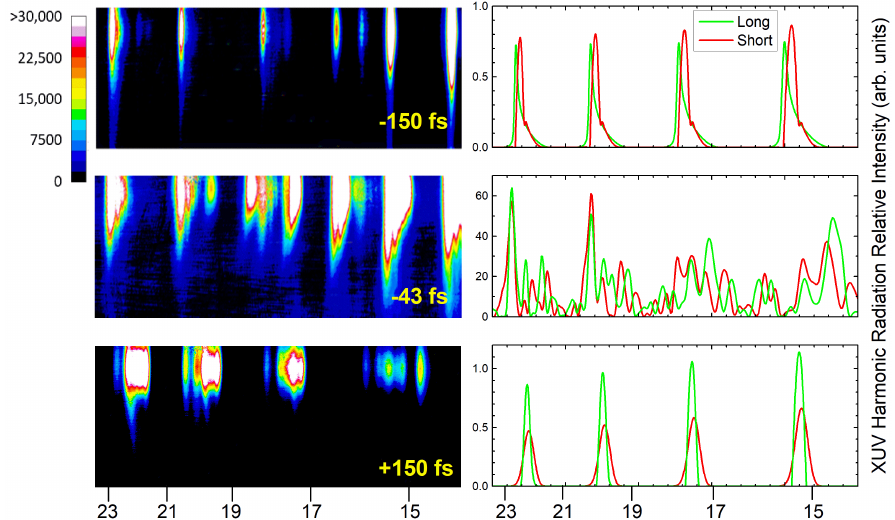
Figure 7. Qualitative comparison between measured XUV harmonic spectral images for chirped laser pulse durations of − 150 fs, − 43 fs, and + 150 fs, corresponding to those presented in Figure 3, and XUV harmonic spectra obtained with our model calculations, corresponding to the experimental conditions of their counterpart XUV harmonic spectral images. Long and short trajectory contributions are included